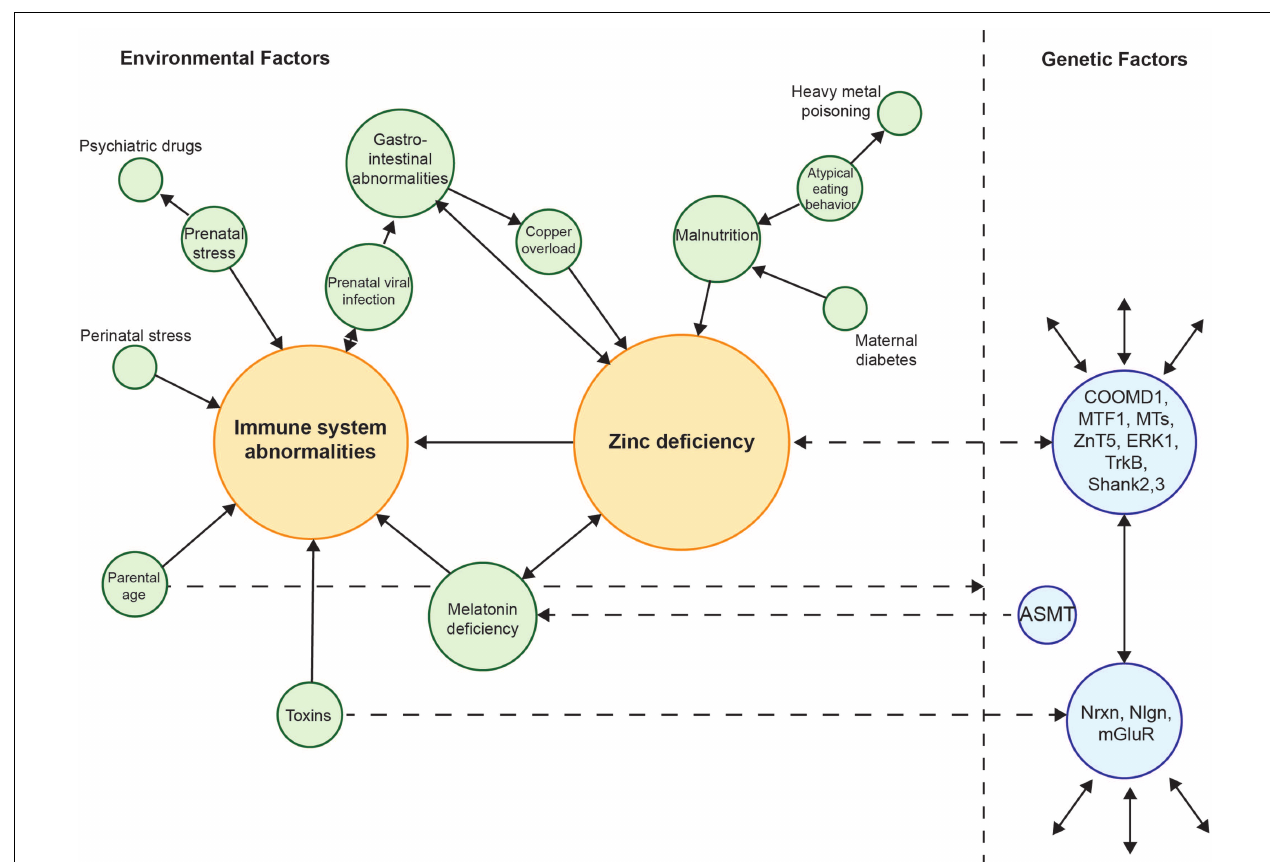
and thus can be placed in the center of the network. Zn 2 + -deficiency, toxins, and the parental age may act on genetic factors providing a crosstalk between genes and environment. Zn 2 + -deficiency and melatonin deficiency in turn can also be caused by genetic